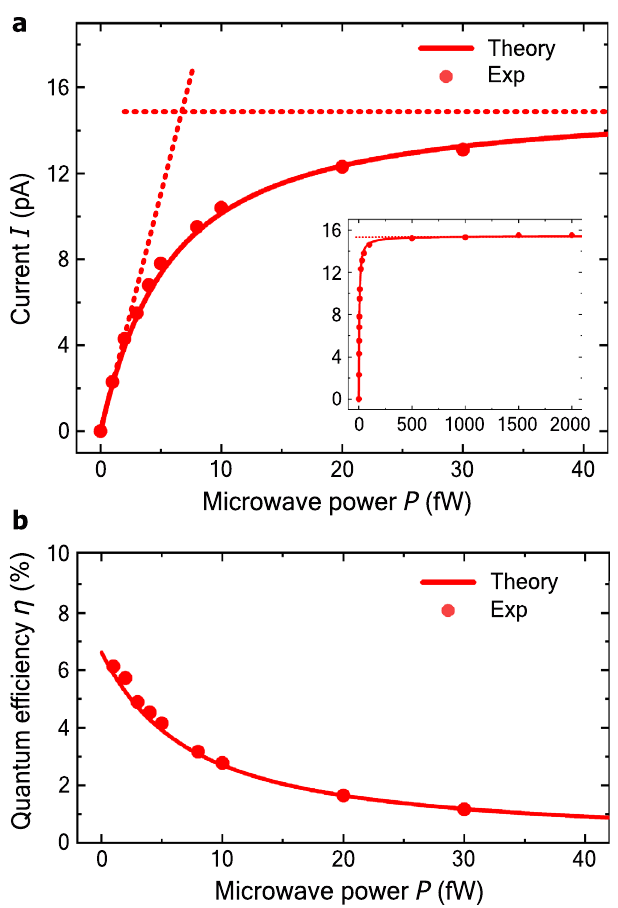
Fig. 2 Photoresponse and quantum ef fi ciency. a Photocurrent I as a function of the ingoing microwave power P . Dots (solid line) present the measured data (theory) and the dashed lines are the theoretical predictions for the low power, linear response current (with η = 6.6%) and the high power saturation current I = 15 pA. The incident microwave drive signal is in resonance with the resonator, f = f r , and the DQD, E = hf , at a detuning δ = + δ fi ciency, Eq. r (c.f. Fig. 3). No bias voltage is applied. b Quantum ef (1), determined from the data of panel a . At 1 fW input power, we experimentally reach 6% ef fi ciency. Exp: experimental